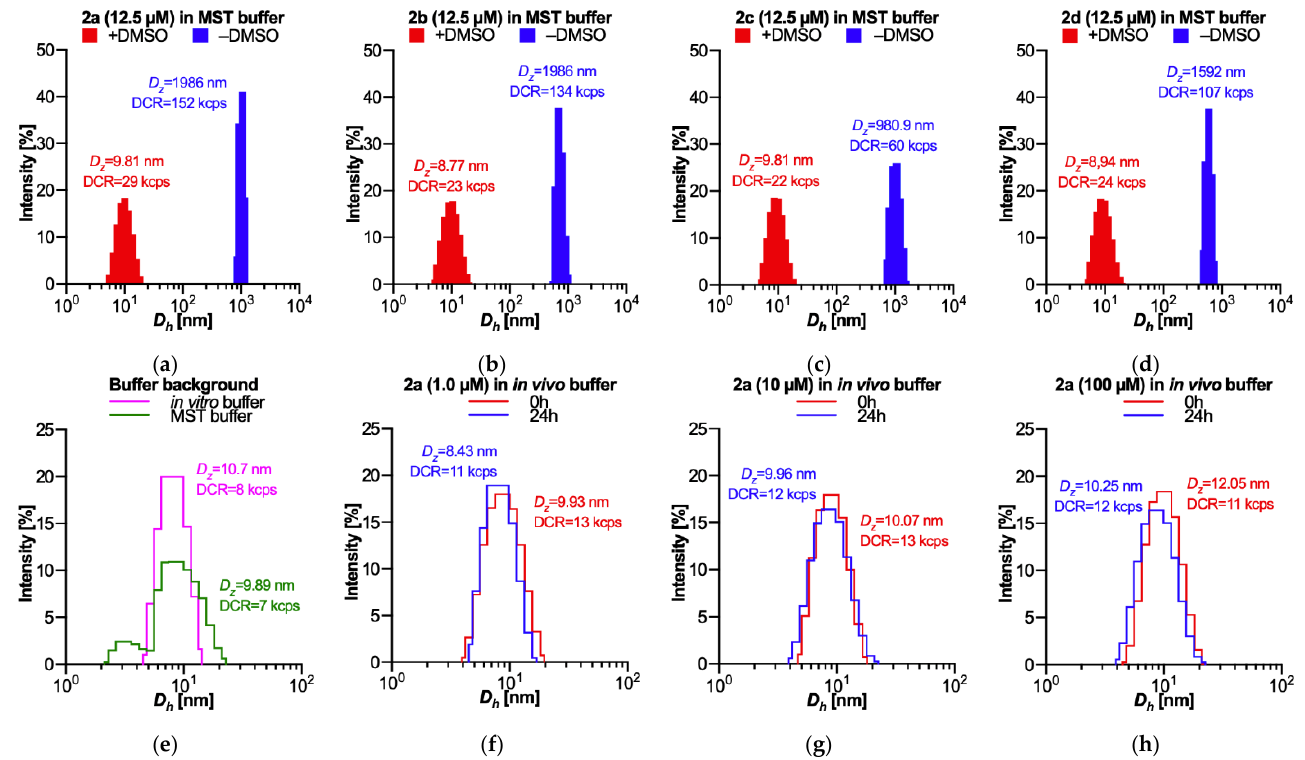
Figure 3. Summary of size distribution of hydrodynamic diameters ( D h ), Z-average hydrodynamic diameters ( D z ) and derived count rates (DCR) for 12.5 µ M solutions of ( a ) 2a , ( b ) 2b , ( c ) 2c and ( d ) 2d in MST buffer (25 mM phosphate buffer, pH 8.0, 500 mM NaCl and 0.05% Tween-20). ( e ) DLS signals from buffers and other background noises. DLS signals before and after 24 h incubation of ( f ) 1.0 µ M, ( g ) 10 µ M and ( h ) 100 µ M solutions of 2a in in vitro assay buffer containing 0.1% Tween-20. No other peaks above 100 nm were detected. All samples obtained from DMSO stocks were measured at a final concentration of 1% DMSO; no serial dilutions were